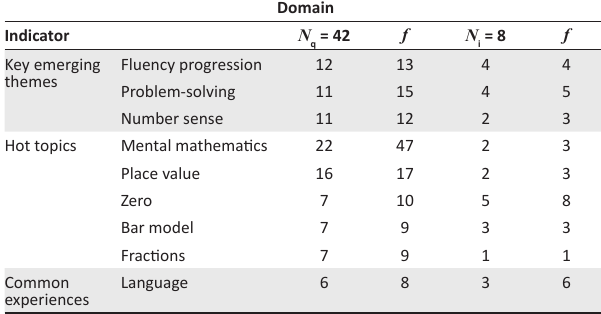
TABLE 1: Utterances of Numeracy Inquiry Community of Leader Educators’ domain-related